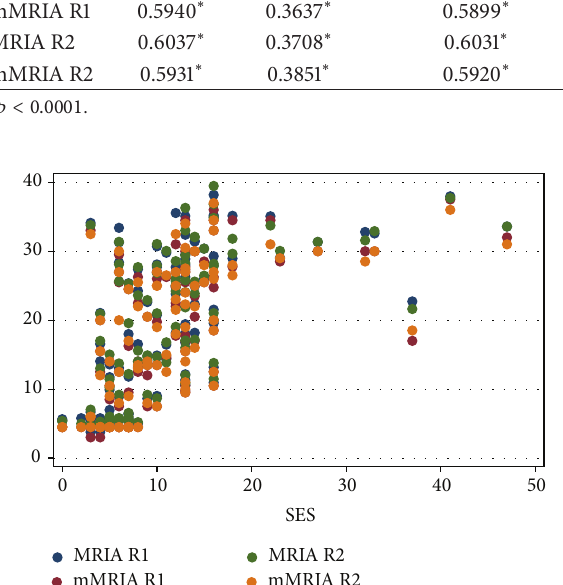
Figure 6: Scatter plot diagram of MRIA and mMRIA versus overall SES values.